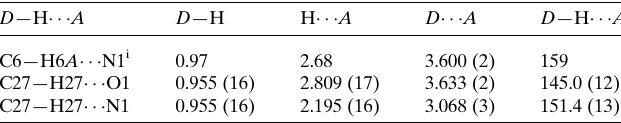
Table 1 Hydrogen-bond geometry (A˚ , (cid:2) ).